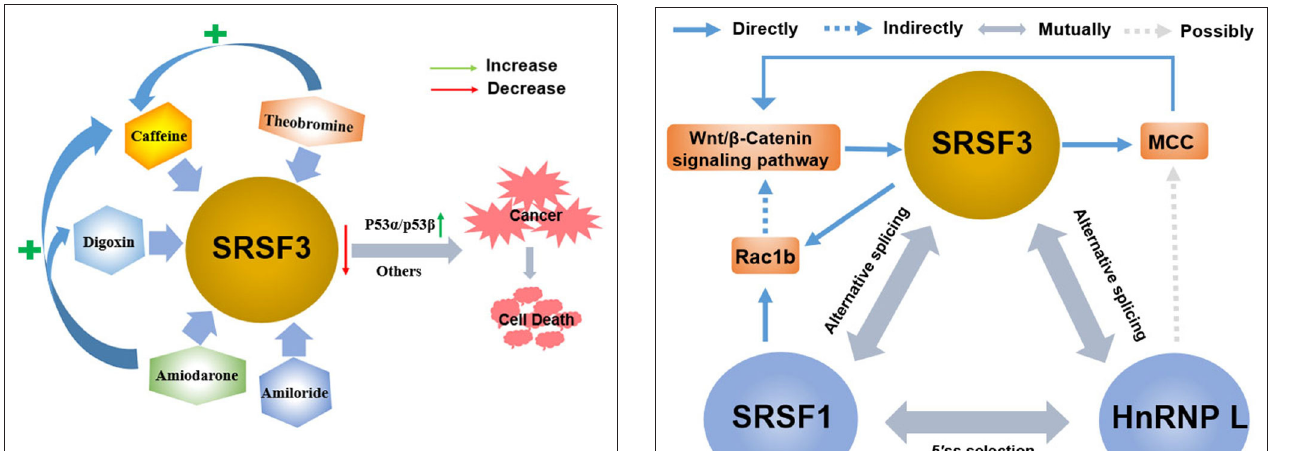
FIGURE 5 | The antitumor function of some drugs via decreasing the expression of SRSF3. Caffeine, digoxin, amiodarone, amiloride, and theobromine induce the apoptosis of cancer cells by decreasing the expression of SRSF3 and its downstream signaling cascade, including inducing the switch of p53 splicing from p53 α to the p53 β isoform. Moreover, theophylline and amiodarone could enhance caffeine-induced cell death, and amiodarone could also enhance the efficacy of digoxin.